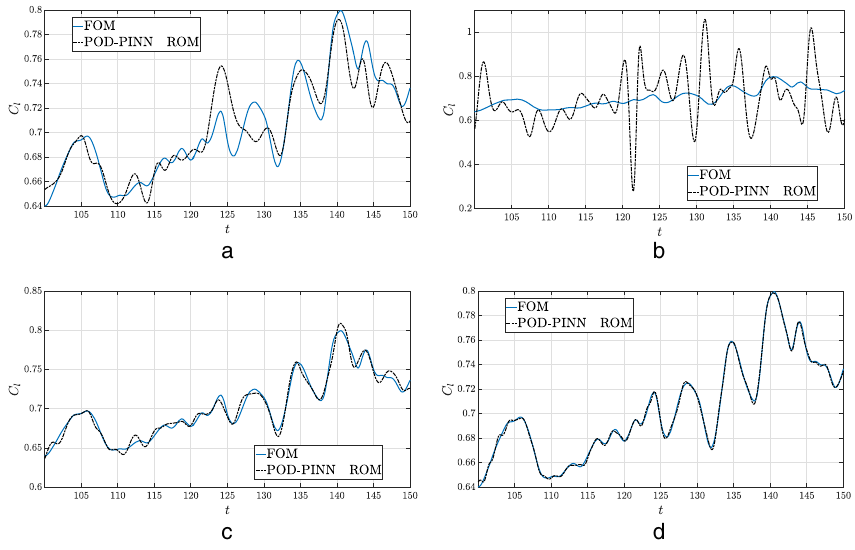
Fig. 17 The Lift coefficients curve over the time range [100 , 150]s. The figures show the one obtained by the FOM solver and the ones approximated by the ROM for different values of and N u , N p and N S . (a) The Lift coefficients curve reconstructed by the ROM using N u = N p = N S = 10 compared to the FOM one. (b) The Lift coefficients curve reconstructed by the ROM using N u = N p = N S = 20 compared to the FOM one. (c) The Lift coefficients curve reconstructed by the ROM using N u = N p = N S = 30 compared to the FOM one. (d) The Lift coefficients curve reconstructed by the ROM using N u = N p = N S = 60 compared to the FOM